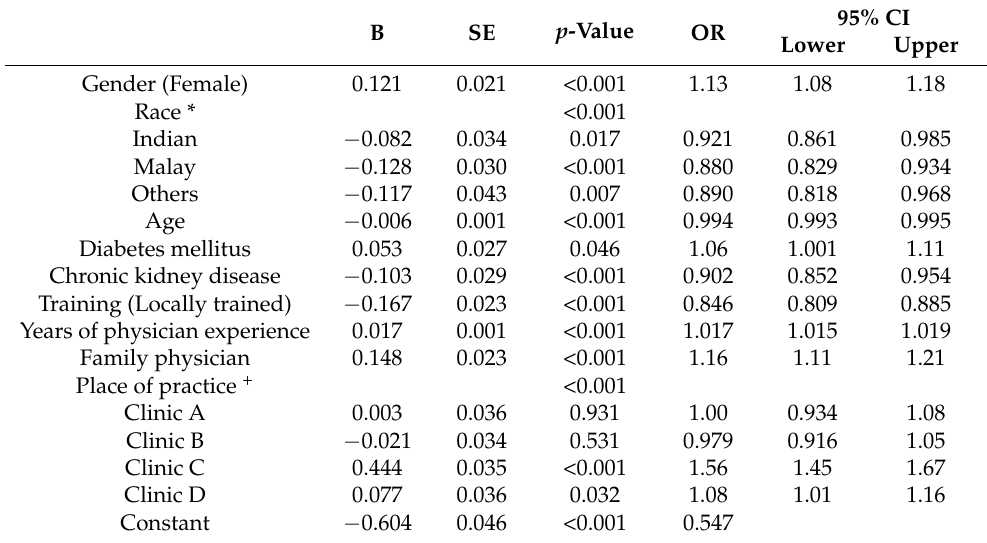
Table A6. Multivariate logistic regression for factors affecting dual topical and oral antibiotic pre- scriptions for skin conditions,